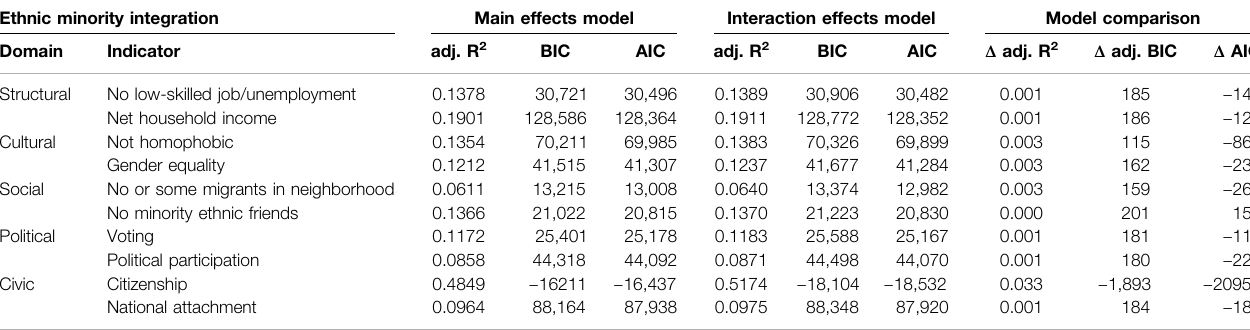
TABLE 4 | Comparing model fi t of models without and with interaction